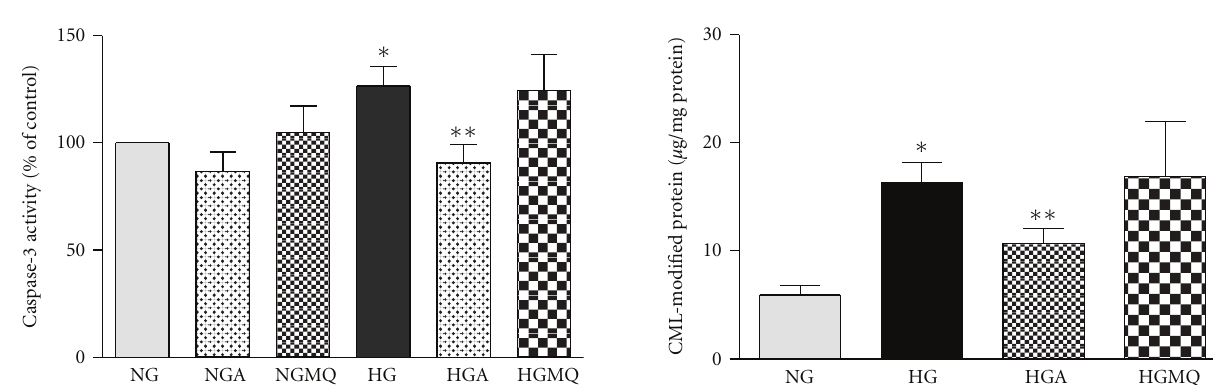
Figure 6: Apocynin reverses glucose-induced CML formation in BRP . Subconfluent cells in 24-well plate were exposed to normal glucose (NG, 5.6 mM) and continuous high glucose (HG, 25mM) and in the presence of 500 μ M apocynin (HGA) or 1 μ M MitoQ (HGMQ) for 4 days. After incubation, the cells were washed twice with ice- cold PBS, lysed and CML were detected using competitive ELISA. Data are presented as Mean ± SEM of 8–13 samples. ∗ P < . 05 versus NG, ∗∗ P < . 05 versus